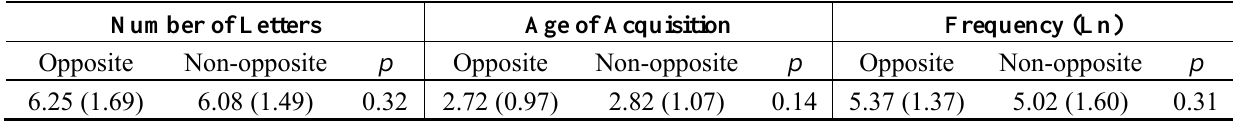
Table 2. Psycholinguistic characteristics of antonym and non-antonym target